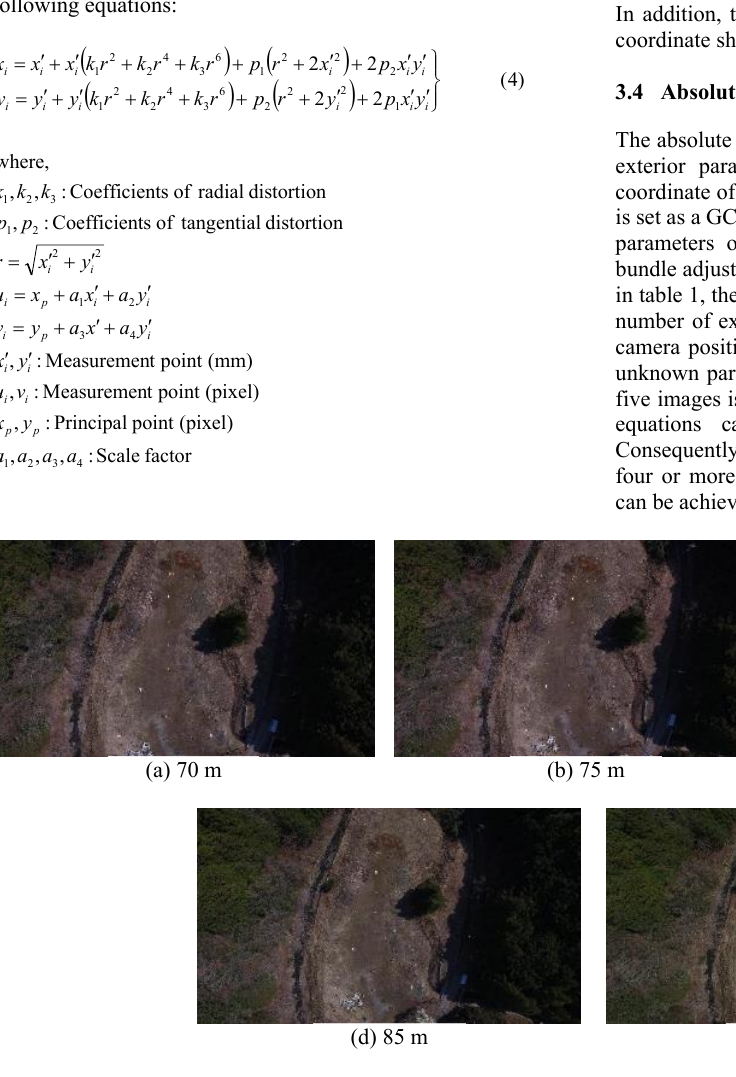
Focal Length (mm)